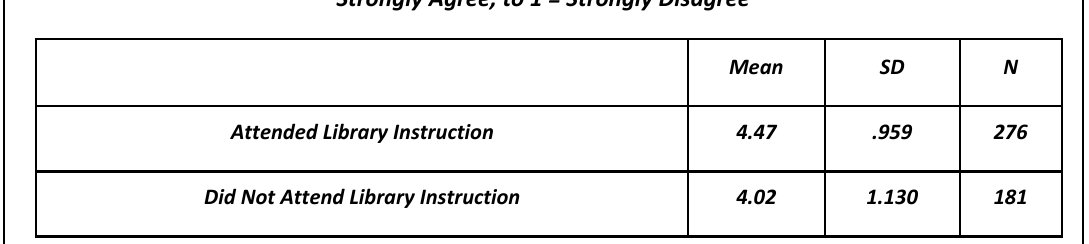
Table 1: Comfort with locating a peer-reviewed article. Based on a five-point scale ranging from 5